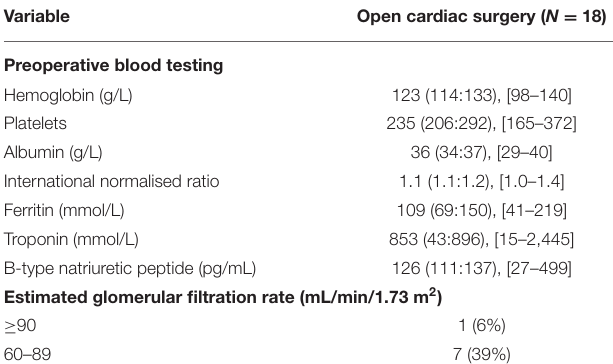
TABLE 2 | Preoperative medications of nonagenarians undergoing open cardiac surgery via a sternotomy. Medication Open cardiac surgery Aspirin